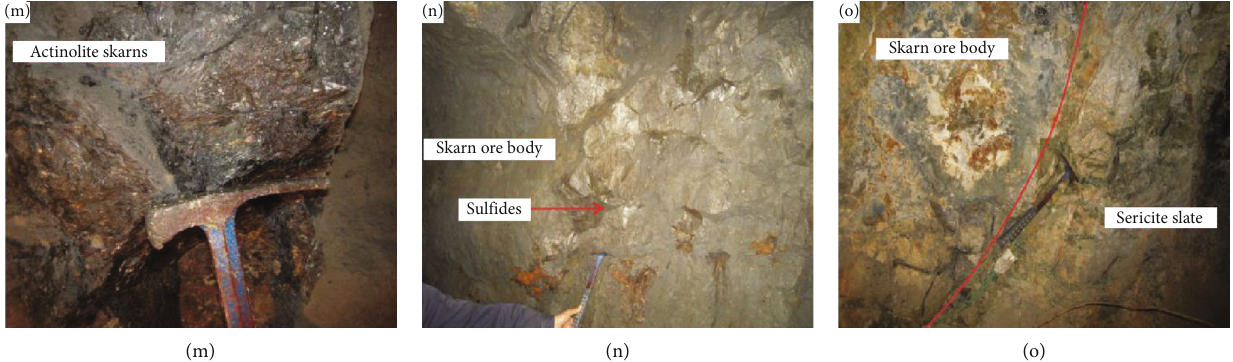
Figure 6: Photographs of stope 41 # in the tunnel 3,250m section, Yangla copper deposit, Yunnan, China. (a) Fault with upper and lower plates of marble and sericitic sandy slate, respectively. The zone ’ s in- fi ll materials include tectonic cataclastic rocks, crushed rocks, and marble breccia. (b) Quartz vein developed within sericitic sandy slate. (c) Interlayer fault developed within sericitic sandy slate. The zone ’ s in- fi ll materials are cataclastic rocks and fault gouge. (d) Irregular contact line between sericitic sandy slate and granite porphyry. (e) Granite porphyry. (f) Quartz – calcite veins with scattered, disseminated sul fi des (pyrite and chalcopyrite) developed in the granite porphyry. (g) Irregular contact line between granite porphyry and skarn ore body. Quartz – sul fi de veinlets developed in the granite porphyry, whereas large amounts of quartz – calcite veins and disseminated metal sul fi des (pyrite and chalcopyrite) developed in the skarn ore body. (h) Skarn ore body with large amounts of veined and disseminated metal sul fi des (pyrite and chalcopyrite). (i) Fault-fracture zone at the fl oor of the skarn ore body. The upper and lower plates are skarn ore body and fault fracture zone, respectively. The zone ’ s in- fi ll materials are tectonic cataclastic rocks. (j) Skarn ore body with quartz veins and large amounts of veined and disseminated metal sul fi des (pyrite and chalcopyrite). (k) Fault – fracture zone between the skarn ore body and skarn. The upper and lower plates are the skarn ore body and the skarn, respectively. The zone ’ s in- fi ll materials are tectonic cataclastic rocks. (l) Garnet skarn. (m) Actinolite skarn. (n) Skarn ore body with large amounts of disseminated pyrrhotite, pyrite, chalcopyrite, and other metal sul fi des. (o) Irregular contact line between skarn ore body and sericitic sandy